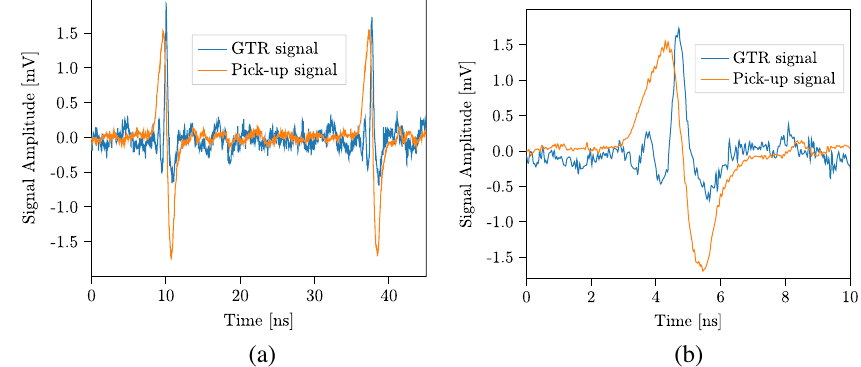
FIG. 17. (a) Two consecutive bunches measured by a pickup and GHz transition radiation monitor spaced apart by 2 m. (b) Enlarged view focusing on the second bunch.